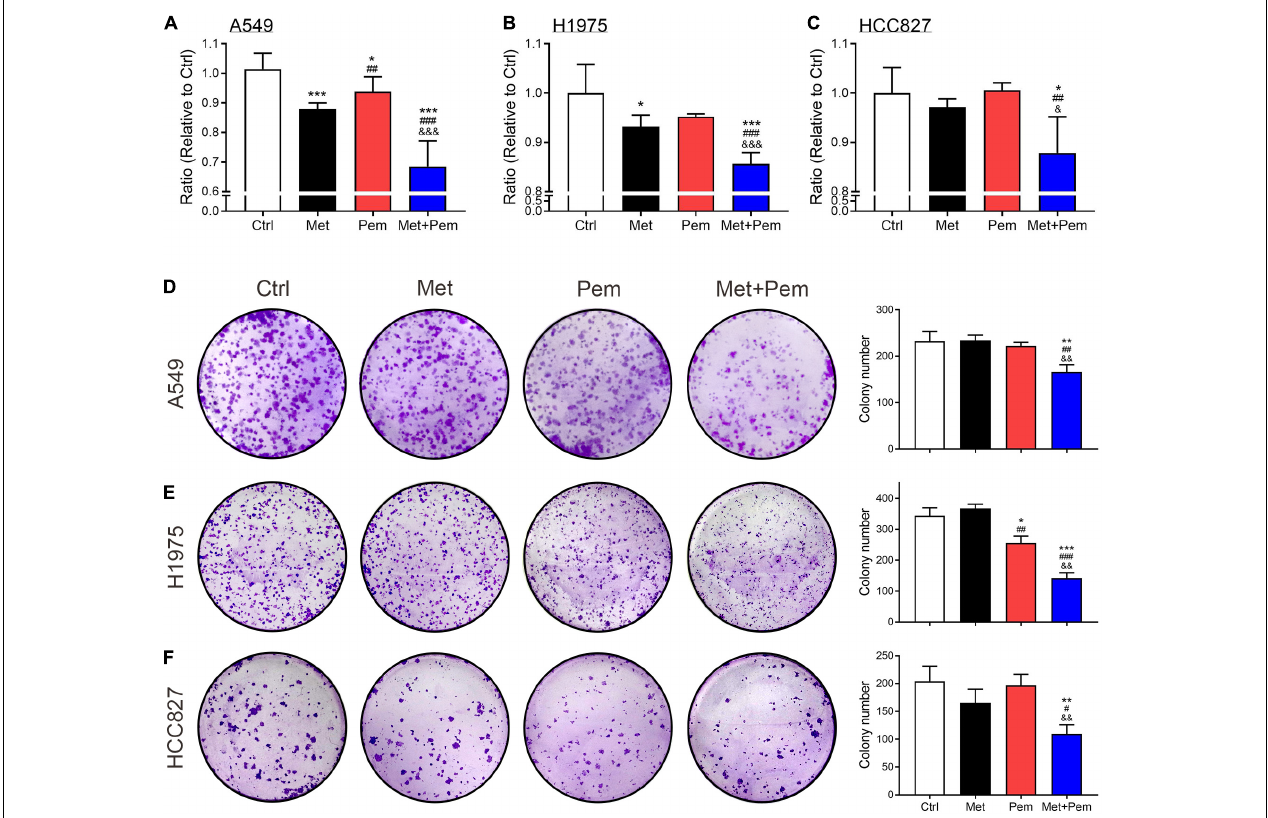
FIGURE 1 | Additive antiproliferative effects of metformin and pemetrexed in the NSCLC cell lines. An MTT assay was used to detect the growth of (A) A549, (B) H1975, and (C) HCC827 cells treated with metformin (0.2 mM) and/or pemetrexed (1 µ M) for 48 h. The ratio of the cell proliferation rate relative to control was calculated. (D–F) A colony formation assay was performed. Three cell lines were seeded at low density (1,000 cells/well) in 12-well plates. After 24 h of adhesion, the cells were treated with metformin and/or pemetrexed for 10 days. The colonies were stained with crystal violet. Representative photographs of each well were taken with a camera. [ (D–F) , right panel] Quantification of the cell colonies by imaging software. The data are presented as the mean ± SD of those from three independent experiments with three technical replicates in each. * P < 0.05, ** P < 0.01, and *** P < 0.001 compared with the Ctrl group; # P < 0.05, ## P < 0.01, and ### P < 0.001 compared with the Met group; & P < 0.05, && P < 0.01, and &&& P < 0.001 compared with the Pem